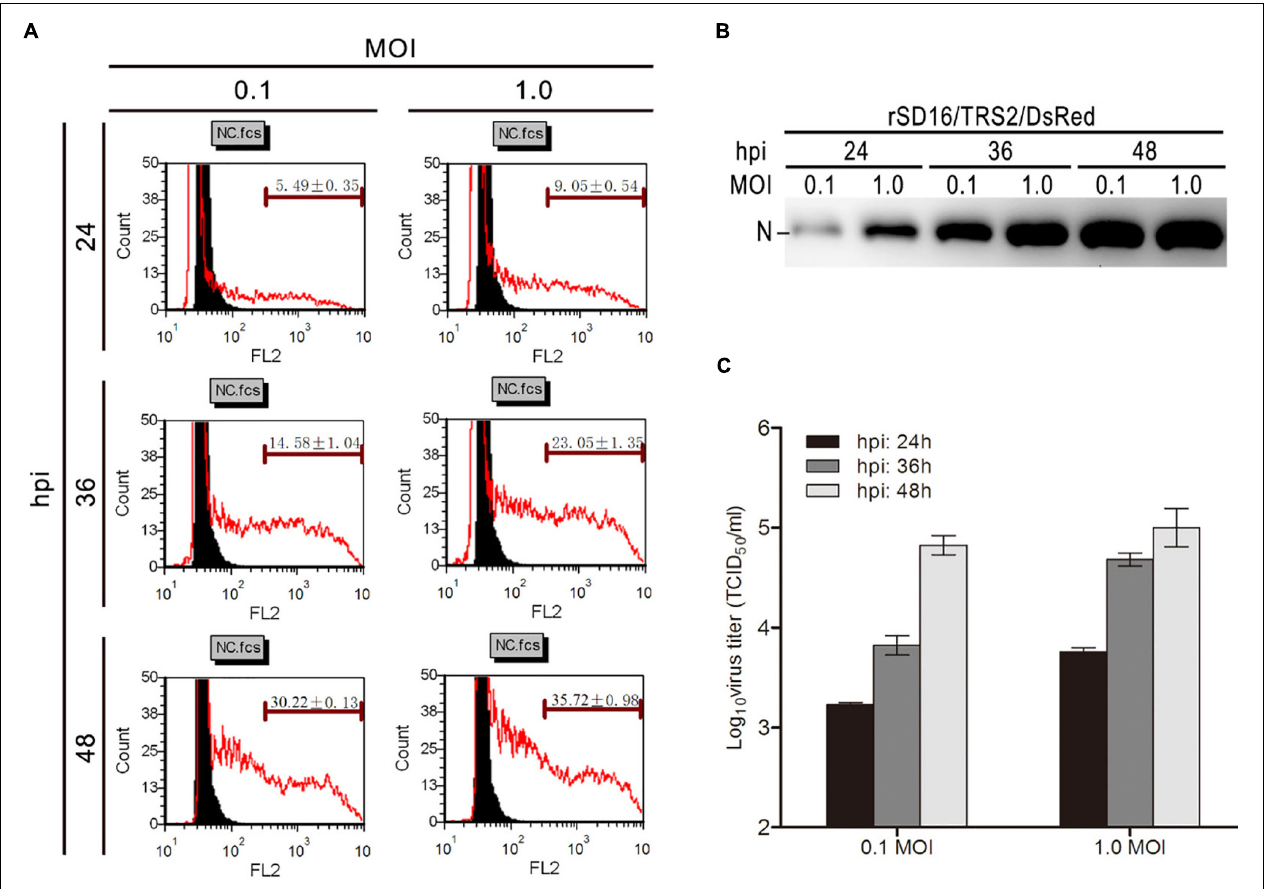
FIGURE 4 | DsRed as an indicator of recombinant PRRSV infection. (A) Different concentrations of DsRed in virus-infected cells detected by flow cytometry; (B) western blot analysis to detect PRRSV N proteins expression after infection with rSD16/TRS2/DsRed; (C) titers of culture supernatant were detected using the TCID 50 method, and all the tests were repeated three